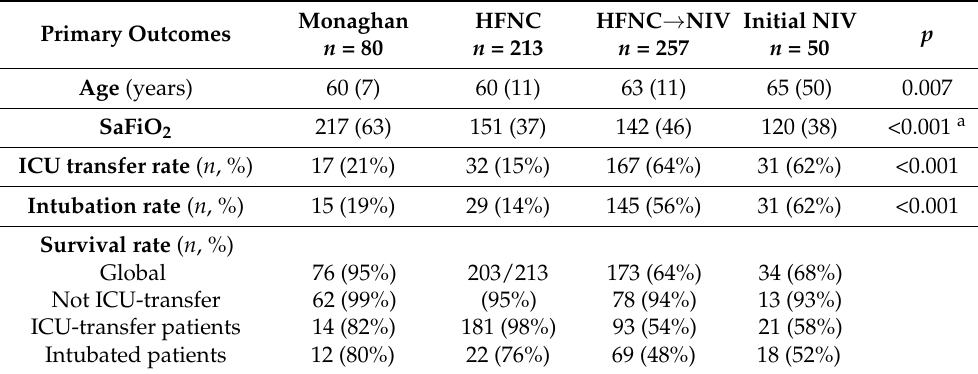
Table 4 summarized outcomes based on NRT during IRCU stay. Table 4. Summarized outcomes based on NRT received during IRCU. a Monaghan group